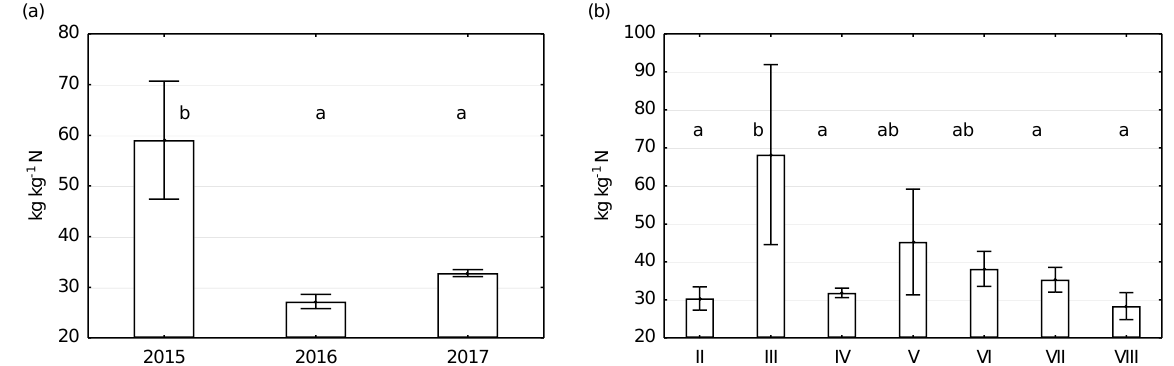
maize grown on the plots fertilized with UAN before sowing and with urea in a top-dress- ing application.